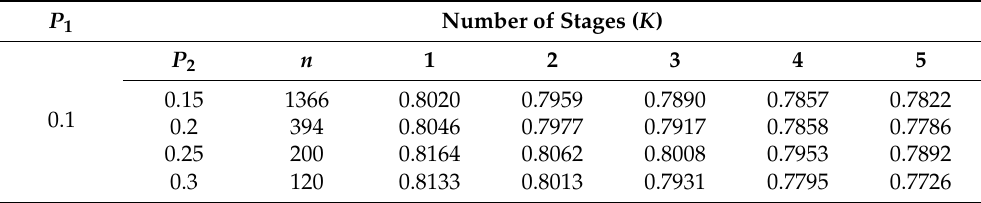
Table 5. Power values for the OWMP with α = 0.05, P 1 = 0.1, and P 2 = 0.15, 0.2, 0.25, and 0.3. P 1